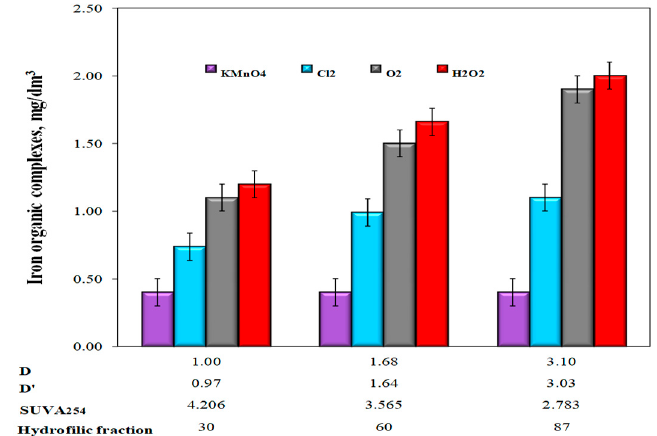
Figure 8. The influence of the type of oxidant and values of the co-occurrence coefficient of organic substances and total iron (D and D’), SUVA 254 value, and the content of hydrophilic organic (%) on the amount of iron-organic complexes in water after the sedimentation substances (%) on the amount of iron-organic complexes in water after the sedimentation process.